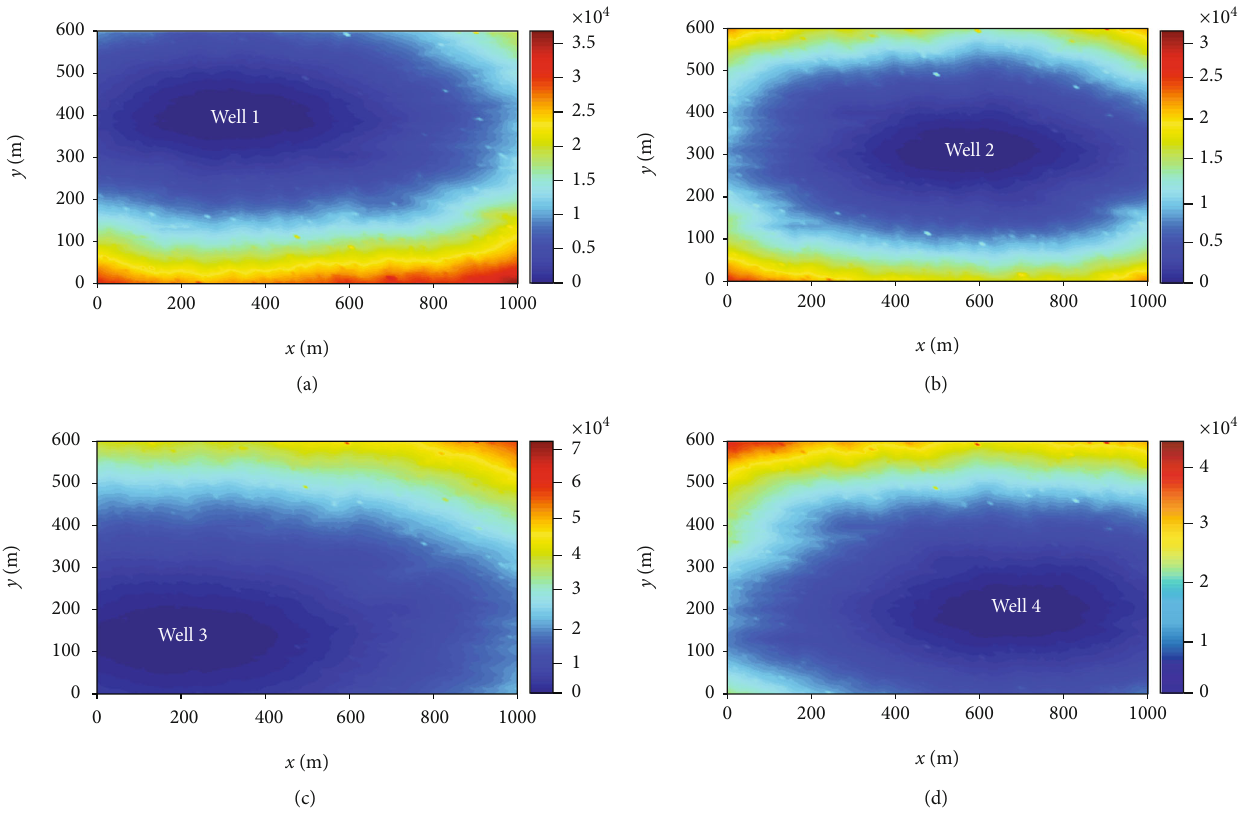
Figure 8: Maps of TOI that are separately calculated with the four fractured wells: (a) TOI of well #1, (b) TOI of well #2, (c) TOI of well #3, and (d) TOI of well #4.